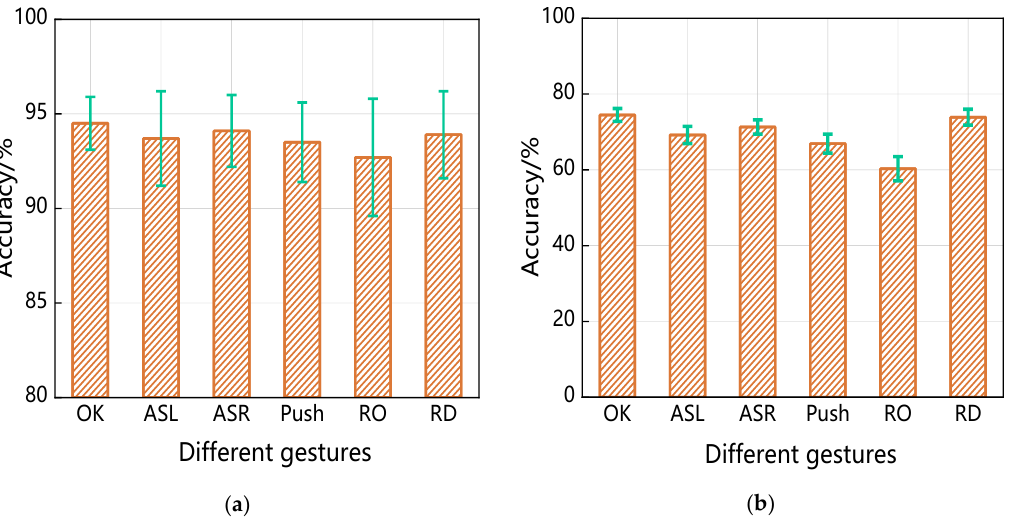
Figure 17. Environmental design: ( a ) Static environment. ( b ) Dynamic environment.